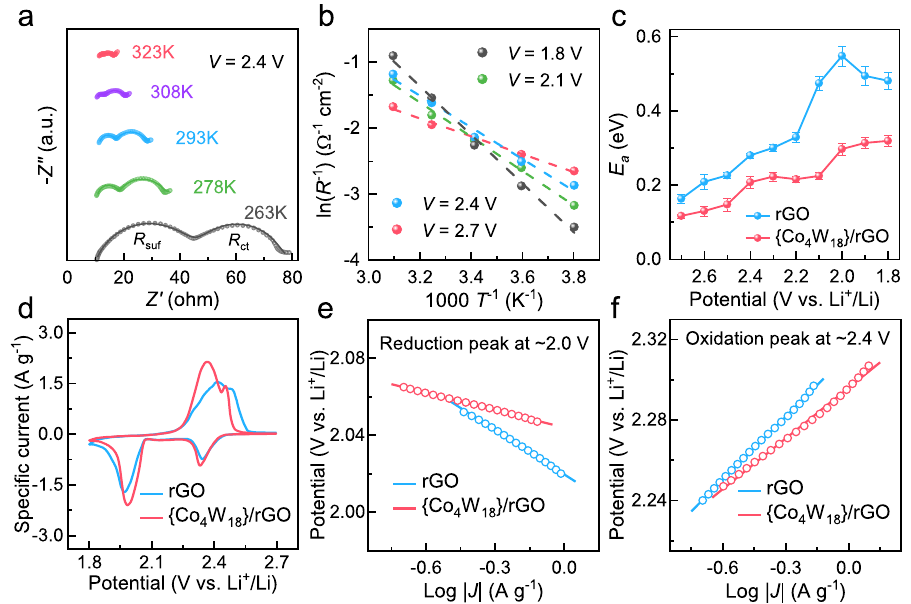
Fig. 4 Activation-energy pro fi les and kinetic analyses of sulfur redox reactions. a Nyquist plots of {Co 4 W 18 }/rGO/S cathodes under different temperatures at 2.4 V. b Arrhenius plots showing the proportional relation between logarithmic values of the reciprocal of charge-transfer resistance and the reciprocal of the absolute temperatures for 2.7 V, 2.4 V, 2.1 V, and 1.8 V. c Activation-energy pro fi les for rGO/S and {Co 4 W 18 }/rGO/S cathodes at various potentials. Error bars derived from the standard deviation of three independent electrodes and the fi tting error. d The fi fth-cycle CV pro fi les of the rGO/S and {Co 4 W 18 }/rGO/S cathodes at a scan rate of 0.1 mV s − 1 . e , f Tafel plots calculated from the reduction peak at ~2.0 V and oxidation peak at ~2.4